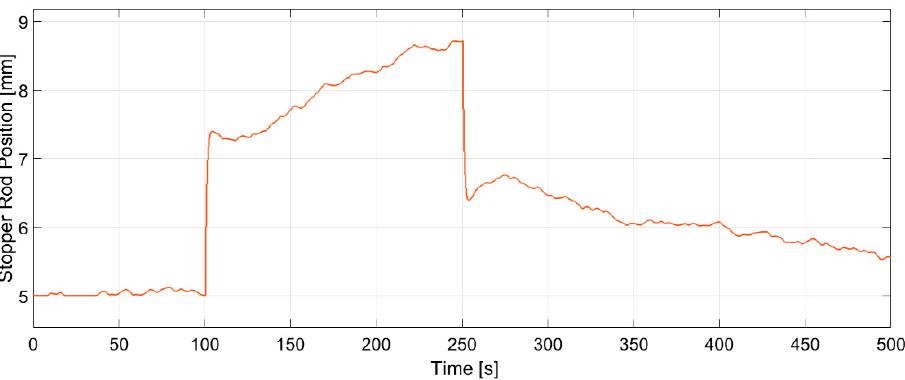
Figure 16. Changes of electromagnetic brake current generated by the controller to track the jet impingement. The manipulated variable does not exceed the constraints of the brake.